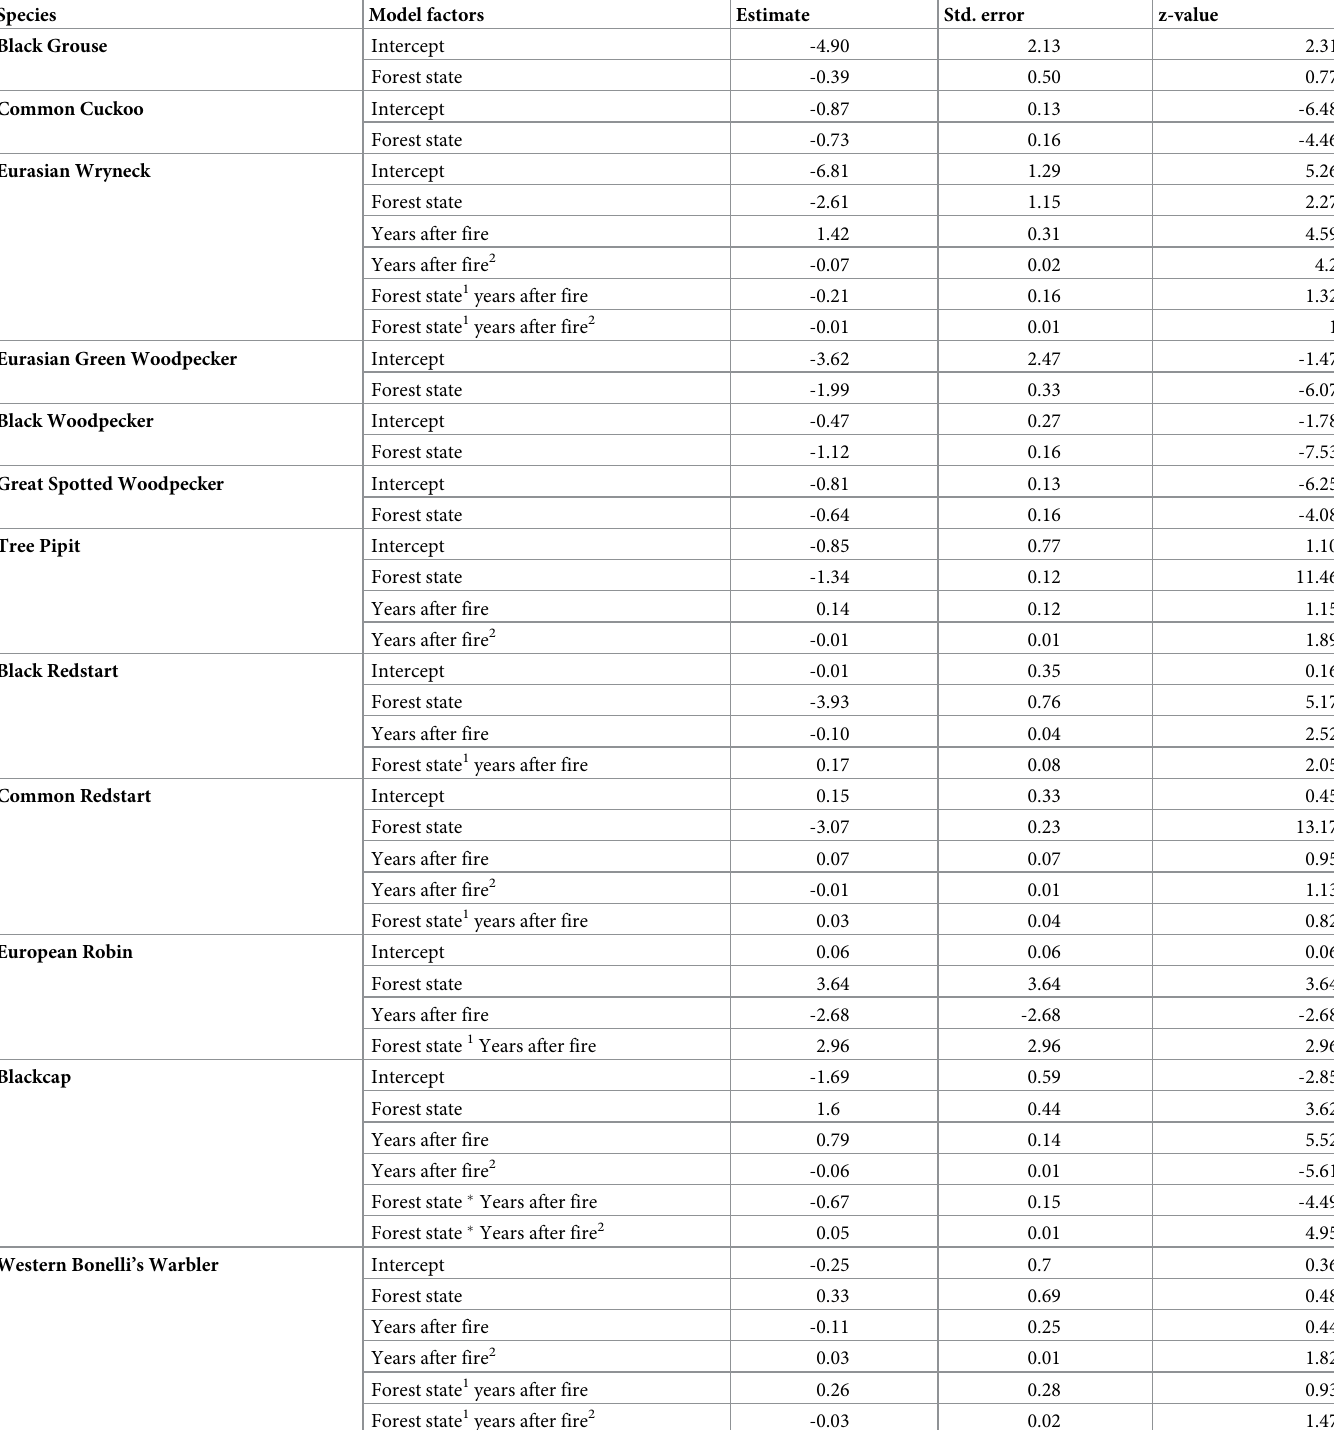
Table 1. Time-dependent effects of forest fire on bird